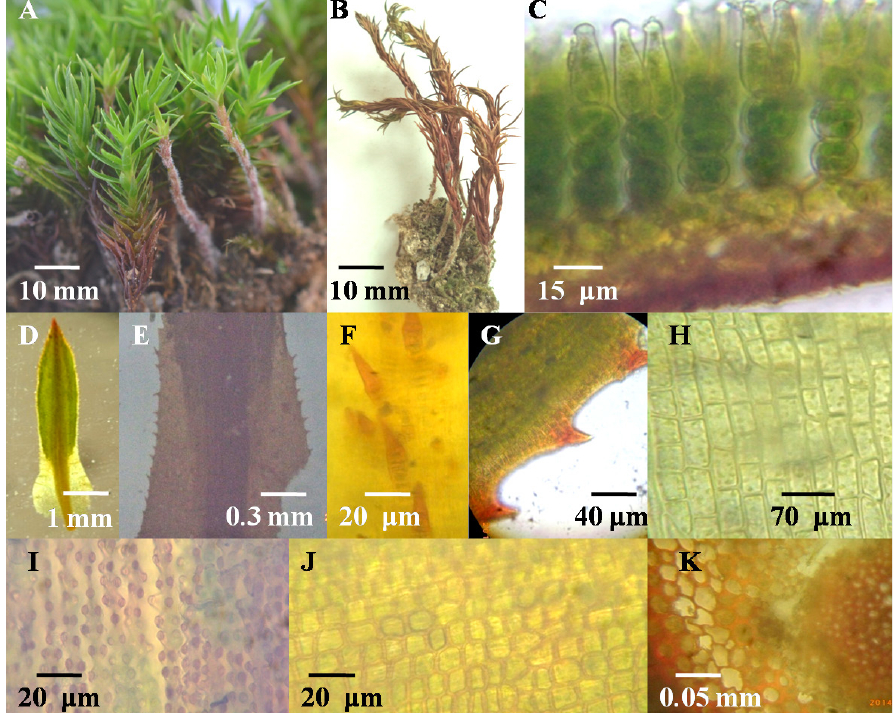
Figure 8: Pogonatum microstomum (R. Br. ex Schwägr.) Brid. (A) fresh habit (B) dry habit (C) transverse section of leaf (D) vegetative leaf (E) leaf shoulder (F) teeth on back side of costa (G) leaf margin (H) leaf sheath cells (I) upper surface of leaf (J) lower surface of leaf (K) transverse section of